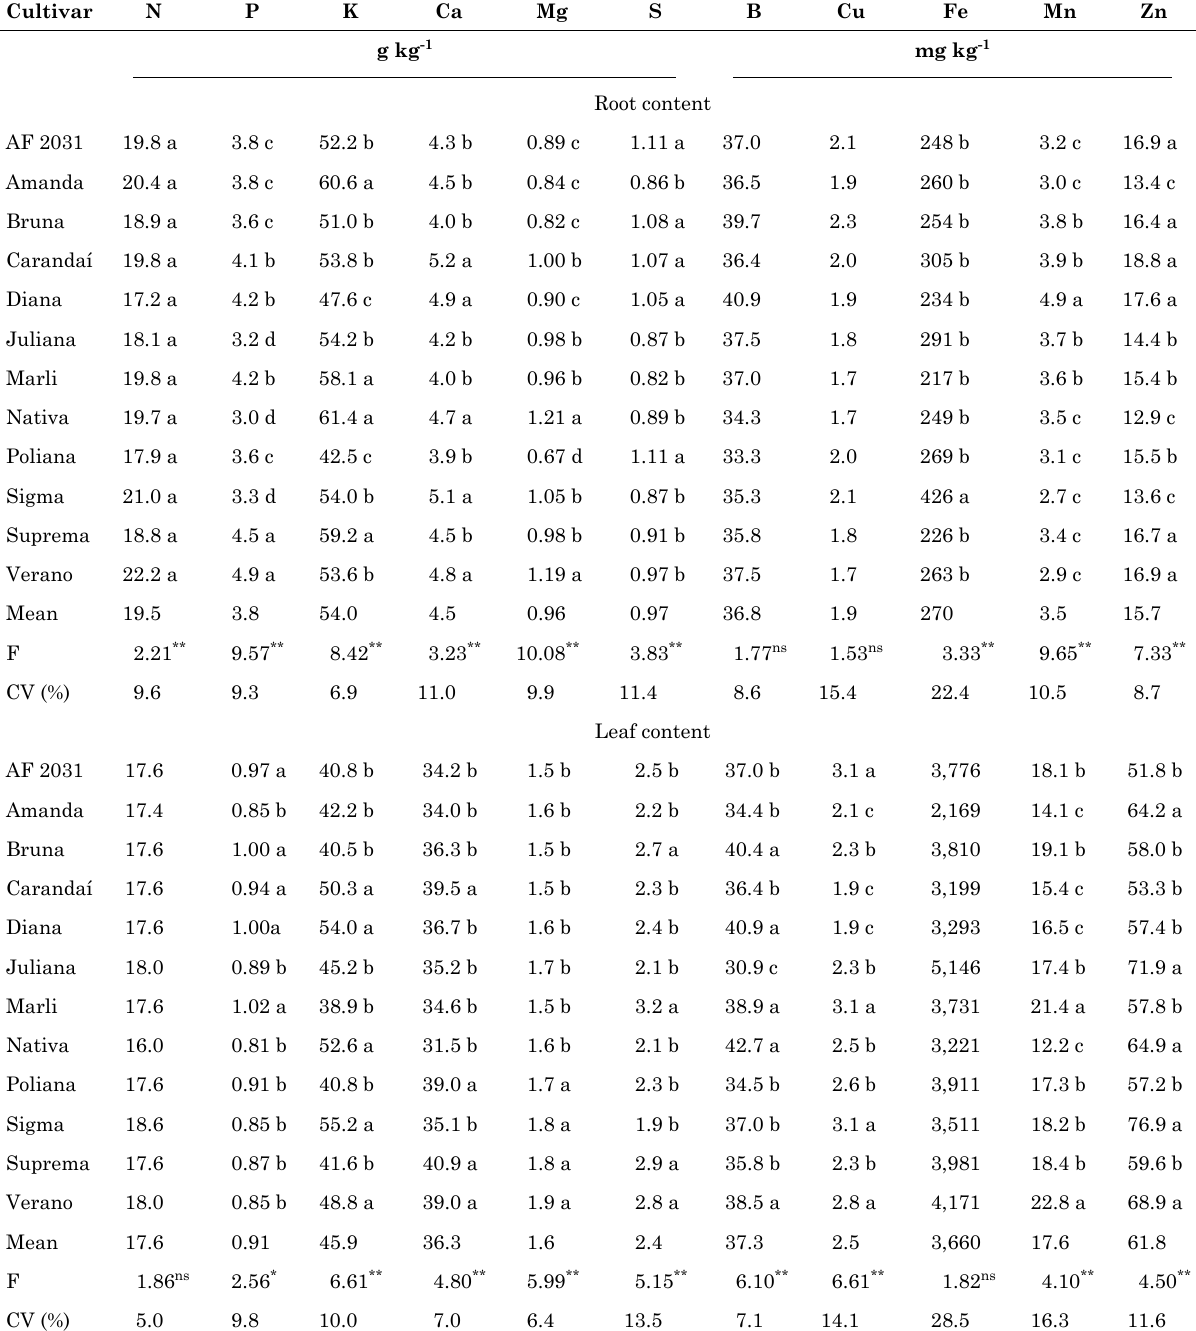
Table 5. Nutrient contents in the roots and leaves of summer carrot cultivars sown in the summer-winter transition crop season (Experiment 2)